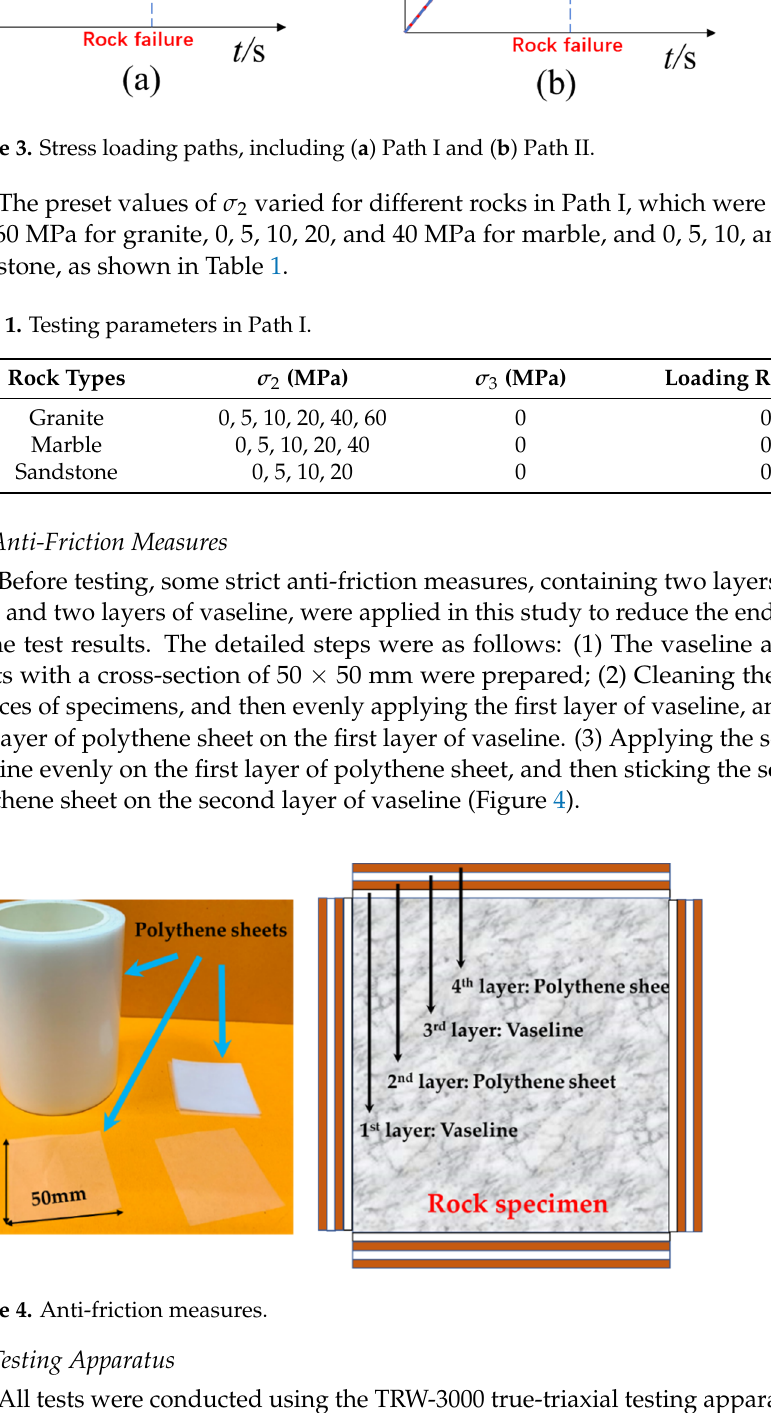
Figure 4. Anti-friction measures.